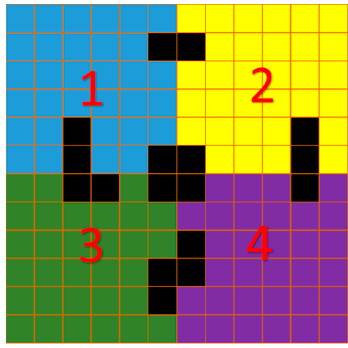
Figure 1. Example of different defective pixel patterns in multi-module pixelated detector; 1, 2, 3, 4 means four adjacent detector modules, black squares represent cluster of defective pixels.